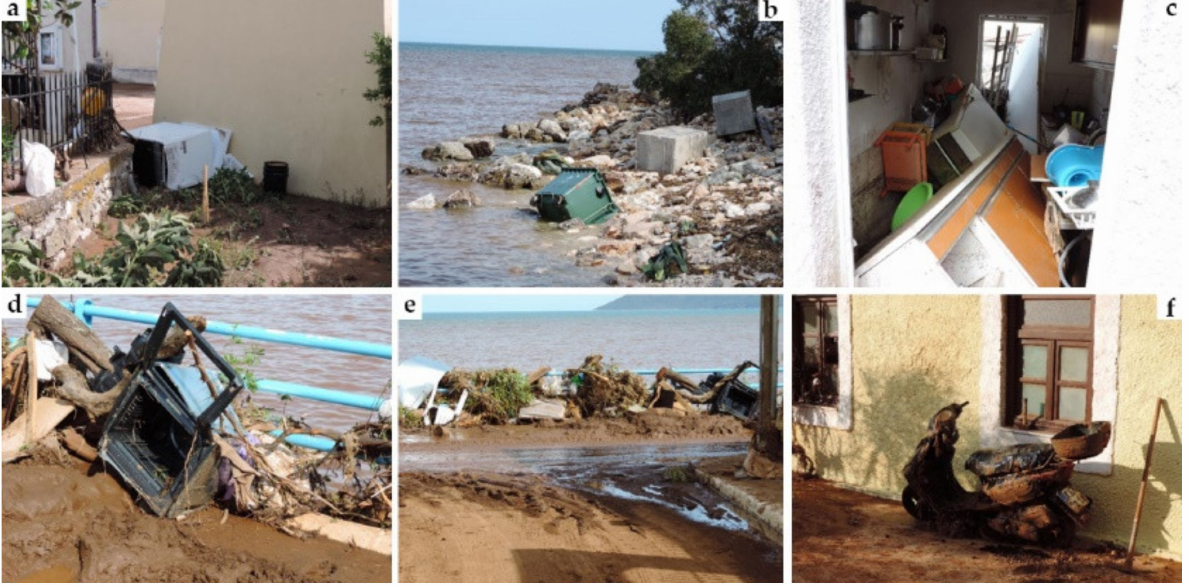
Figure 13. Characteristic images of mobile objects of various sizes transported by floodwaters ( a – f